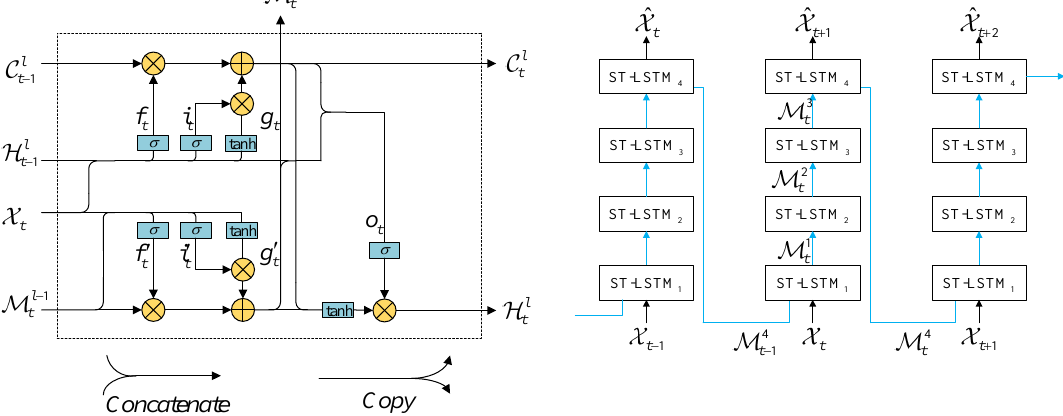
Figure 3. ( a ) The internal structure of the ST-LSTM. ST-LSTM originates from the basic structural unit of ConvLSTM, with the addition of the spatiotemporal memory state M t as its feature. ( b ) The propagation of the spatiotemporal memory. The blue arrows indicate that the spatiotemporal state M t is propagated in a zigzag pattern throughout the network.